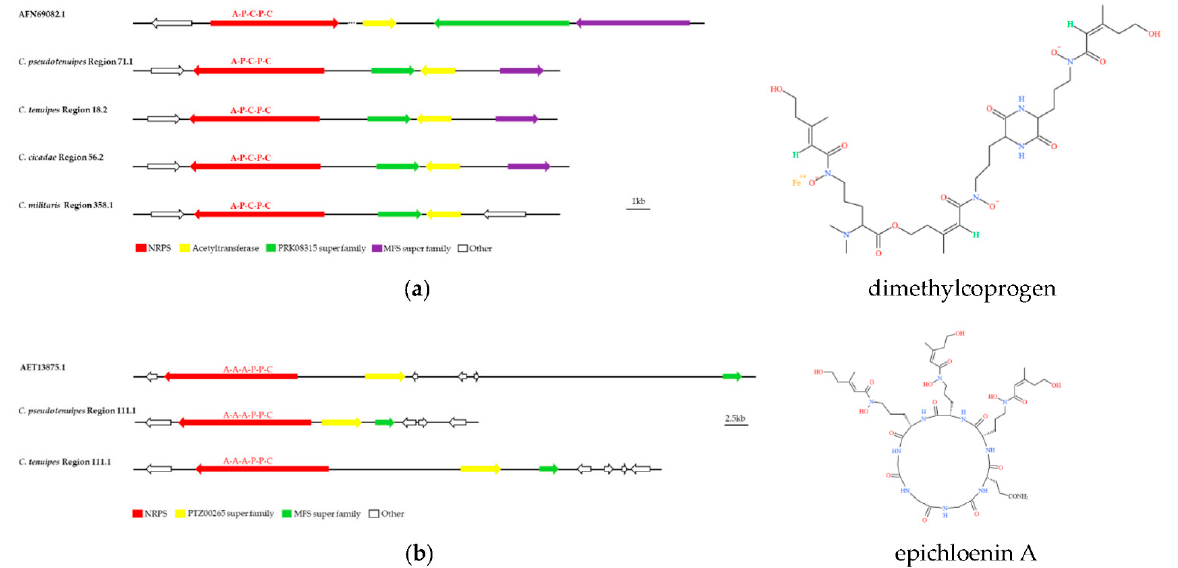
Figure 5. Comparison of BGC constituents in C. pseudotenuipes , C. tenuipes , C. militaris, and C. cicadae with identified BGCs for putative biosynthesis of dimethylcoprogen ( a ) and epichloenin A ( b ). The number after the region and the number before the decimal point represent the scaffold, and the number after the decimal point represents the gene cluster.